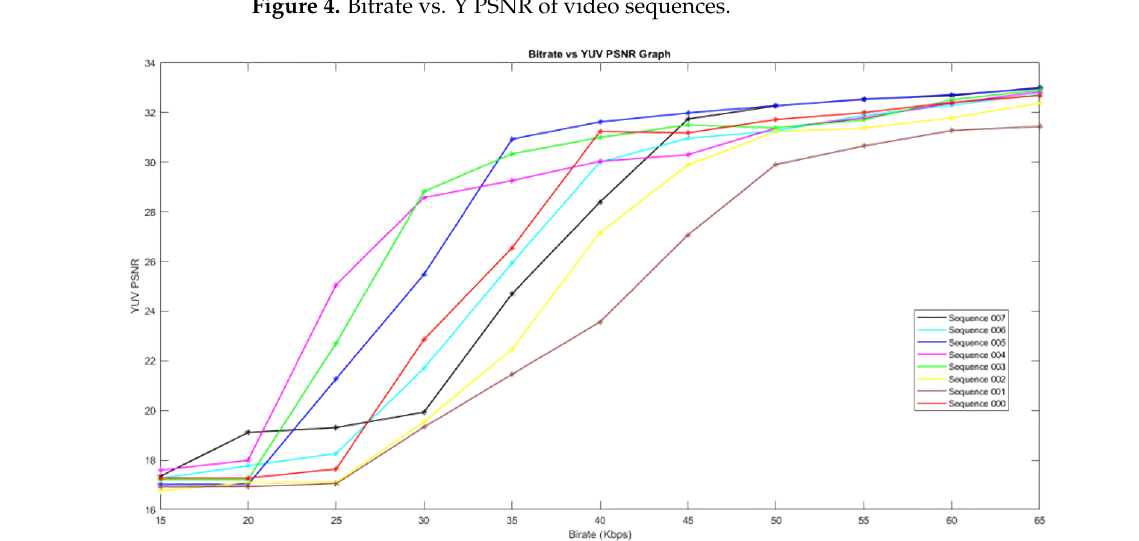
Figure 5. Bitrate vs. YUV PSNR of video sequences.